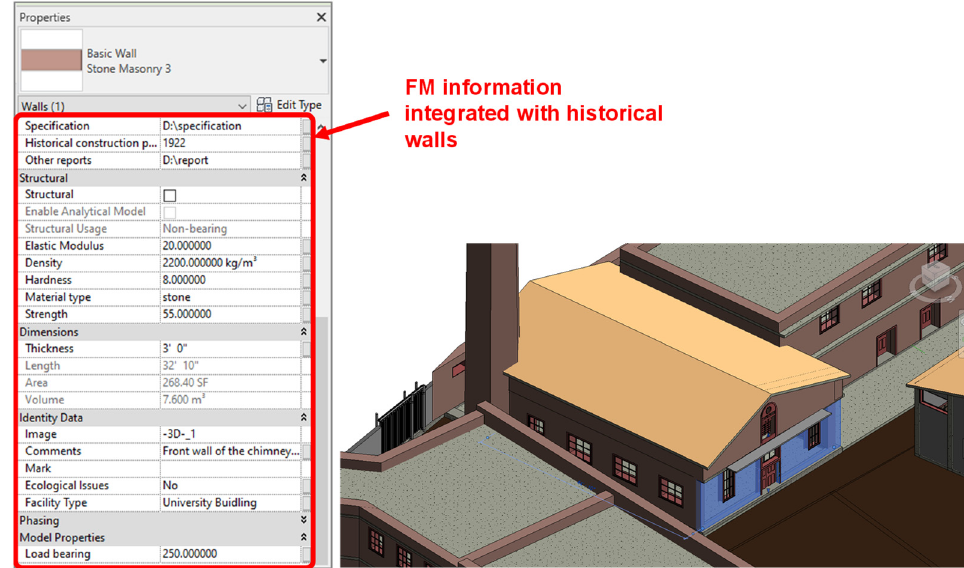
( d ) Figure 11. 3D HBIM model of the NED campus: ( a ) 3D BIM model of the case study; ( b ) top view of the case study model; ( c ) actual site picture of the shed-like structure captured by the authors; and ( d ) digital view of the shed-like structure. 5.3. NED HBIM Model Integration The semantic information specifically related to the FM is added to the heritage com- ponents, such as walls, doors, windows, etc., to enhance their functionalities and support the different tasks. The current information in the Revit software integrated with the her- itage components is not enough to support our goal because it contains very specific and built-in information. However, it supports the definition of new parameters, such as pro- ject or shared parameters assigned to the heritage BIM components. Therefore, new pa- rameters significant for the heritage FM works were defined as shared parameters because they can be exported to the external database management system. Furthermore, the information available in the digital format, such as CAD drawings, PDF reports, and documents from the previous restoration activities and the specification